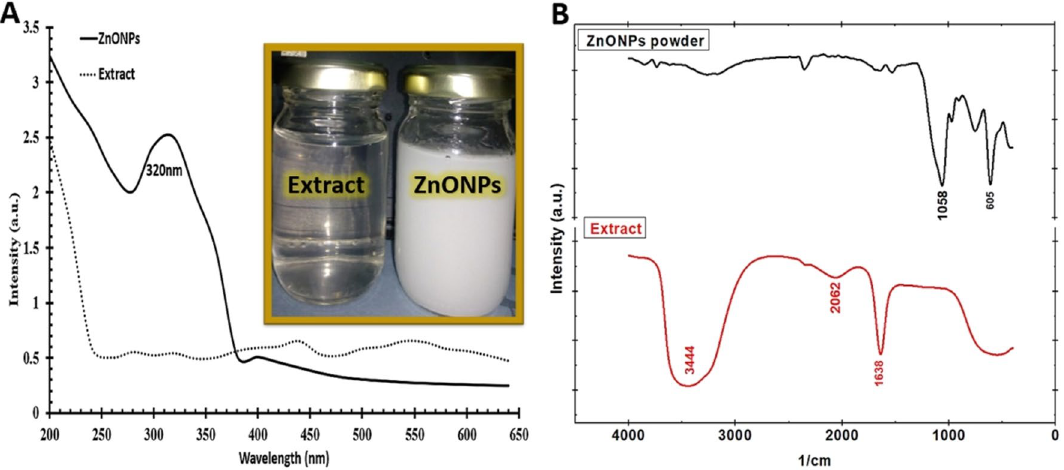
Figure 3. ( A ) UV–visible absorption spectra of ZnO NPs and cell-free mixed extract; (B) FT-IR spectroscopy of used mixed extract and biosynthesized ZnO NPs; besides the photos appeared the changing color of mixed cell-free extract into white color that confirmed the bio-synthesis process of ZnO